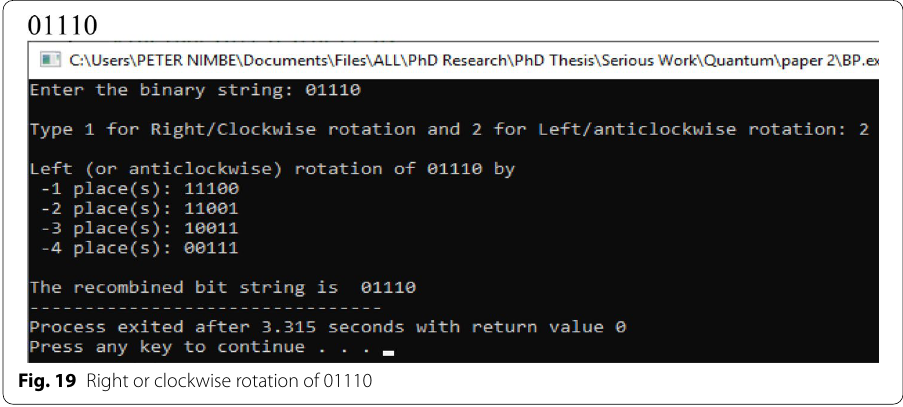
Fig. 19 Right or clockwise rotation of 01110